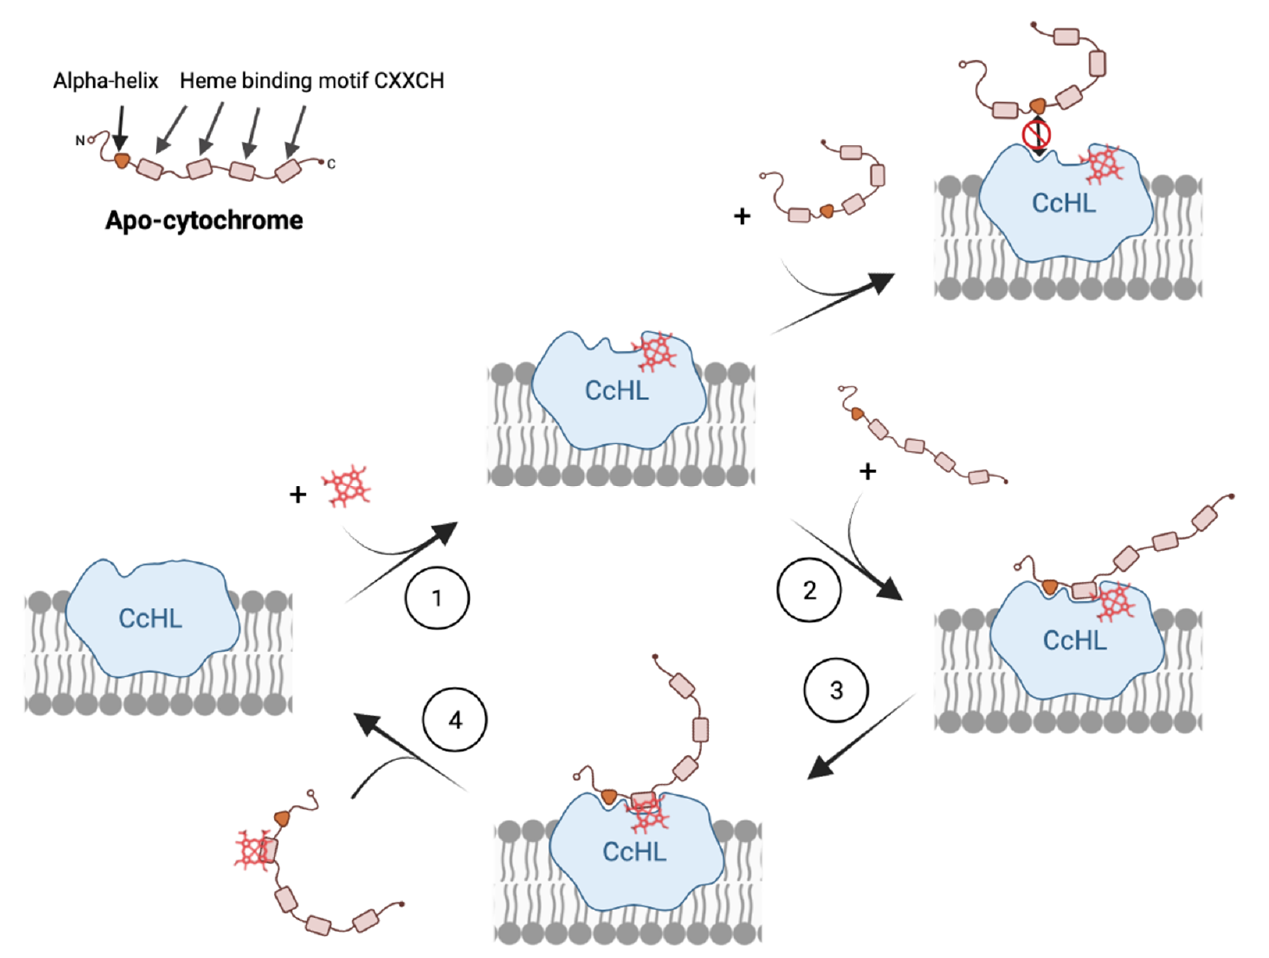
Figure 4. Model for the molecular mechanism of cytochrome- c maturation by System III.